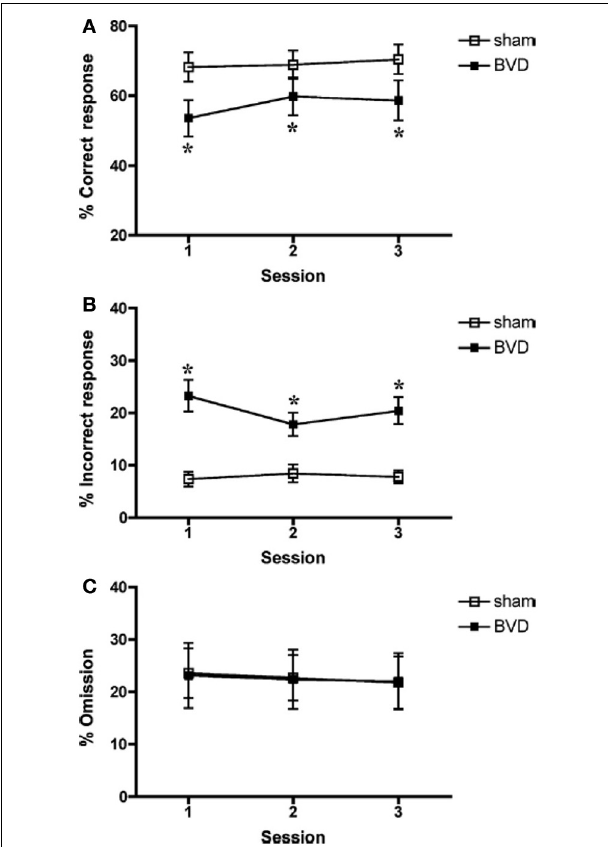
FIGURE 5 | Percentage of correct responses (A), incorrect responses (B), and omissions (C) for sham (open square) and BVD rats (closed square) in a 5 choice serial reaction time task in light. Data are expressed as means ± s.e.m. Asterisks indicate significant differences. Reproduced with permission from Zheng et al. (2009a,b).